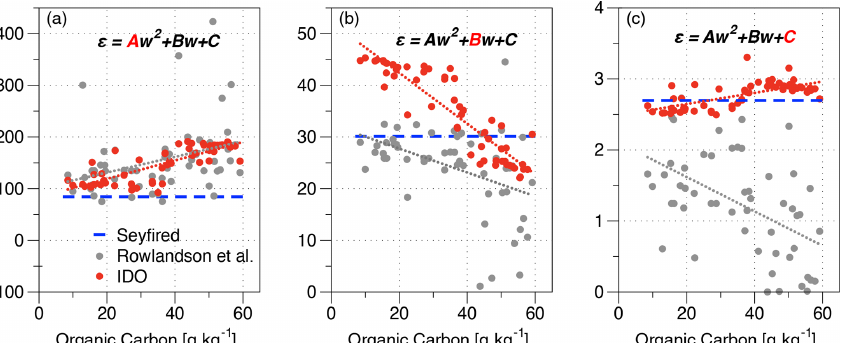
Figure 4. Relationship between soil organic carbon measurements ( x axis) and calibration parameters ( A , B , and C ) ( y axis) relating between measured dielectric constant ( ε ) and volumetric soil moisture ( w ): (blue dash lines) A , B , and C , which are not sensitive to OC measurements (Seyfried approach); (gray dots) A , B , and C , which are empirically obtained (Rowlandson et al., 2013); (red dots) A , B , and C , which are physically simulated by the proposed IDO, which applies the wilting point and porosity as functions of sand and clay volumetric mixing ratios as well as soil organic carbon with the damping factor applied.